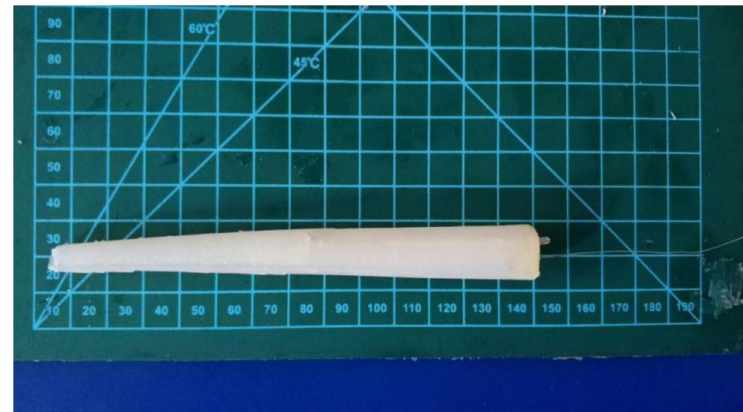
Figure 1. Design of cable-driven soft arm Table